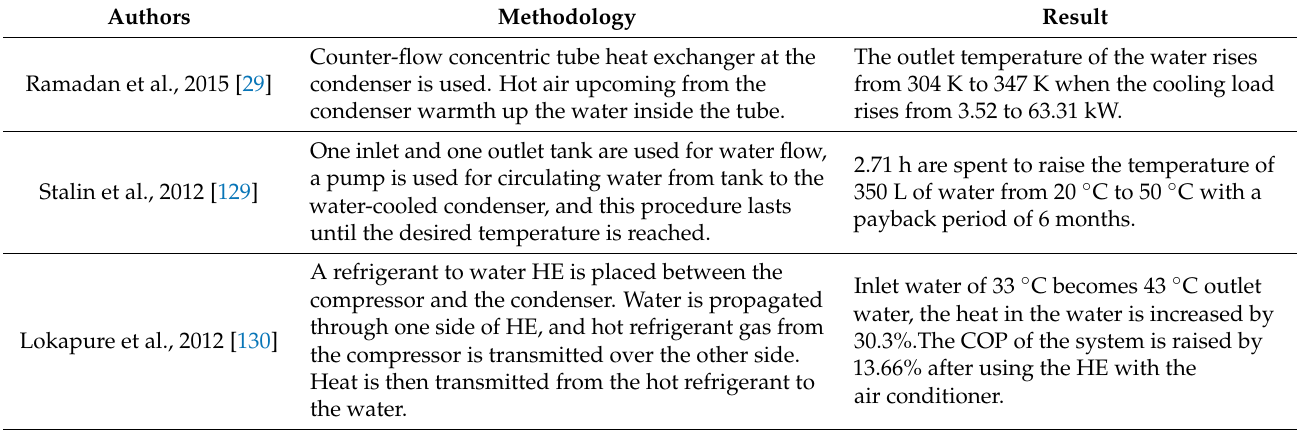
Table 2. Summary of the investigated papers related to heating water for domestic use from the lost